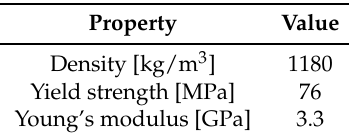
Table 2. Main mechanical characteristics of PMMA (ISO 527-2).